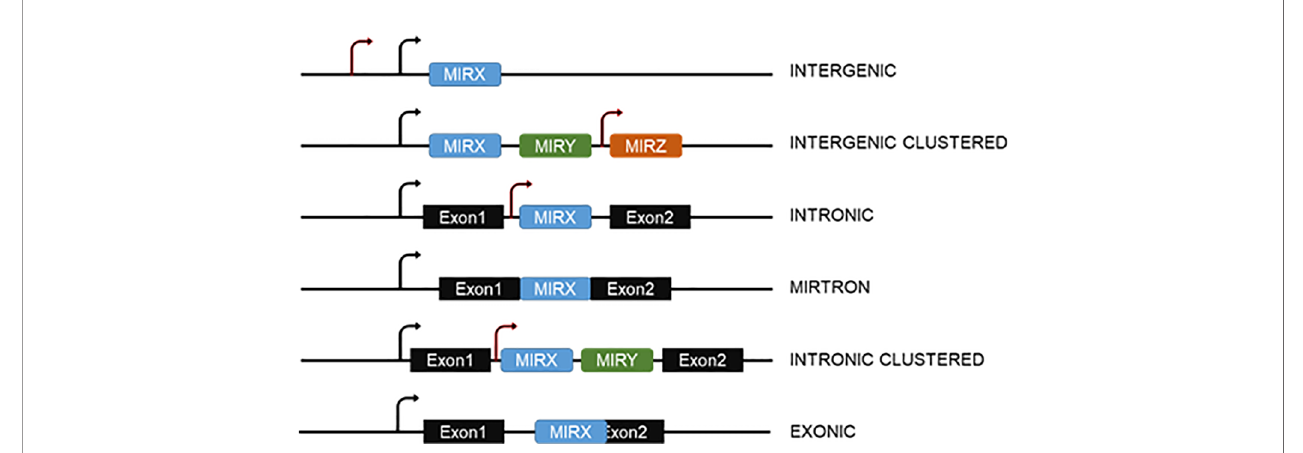
FIGURE 1 | Genomic organization of miRNA genes. MiRNAs can be intergenic or be encoded within introns or overlapping exons of other genes. In both cases, they can be in clusters with other miRNAs. Mirtrons are generated from spliced-out introns and do not require the action of the Microprocessor. The arrows indicate the possibility of more than one transcription start site for both intergenic or intragenic